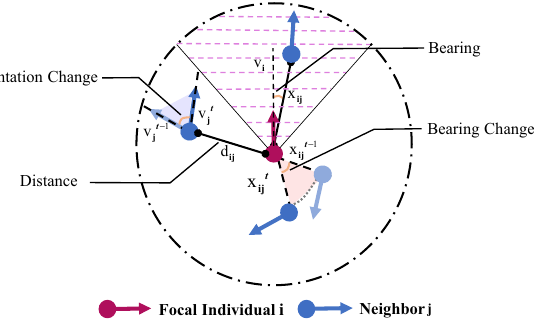
Figure 1. An illustration of the featured factors. Pink striped area represents the frontal preference of the focal individual i . d ij = || x i − x j || is the distance between individuals i and j (Eq. (3)); x ij = x j − x i is the relative position of j with respect to i (Eq. (4)); v j t , v j t − 1 are the velocity vector of individual j at time t and t − 1